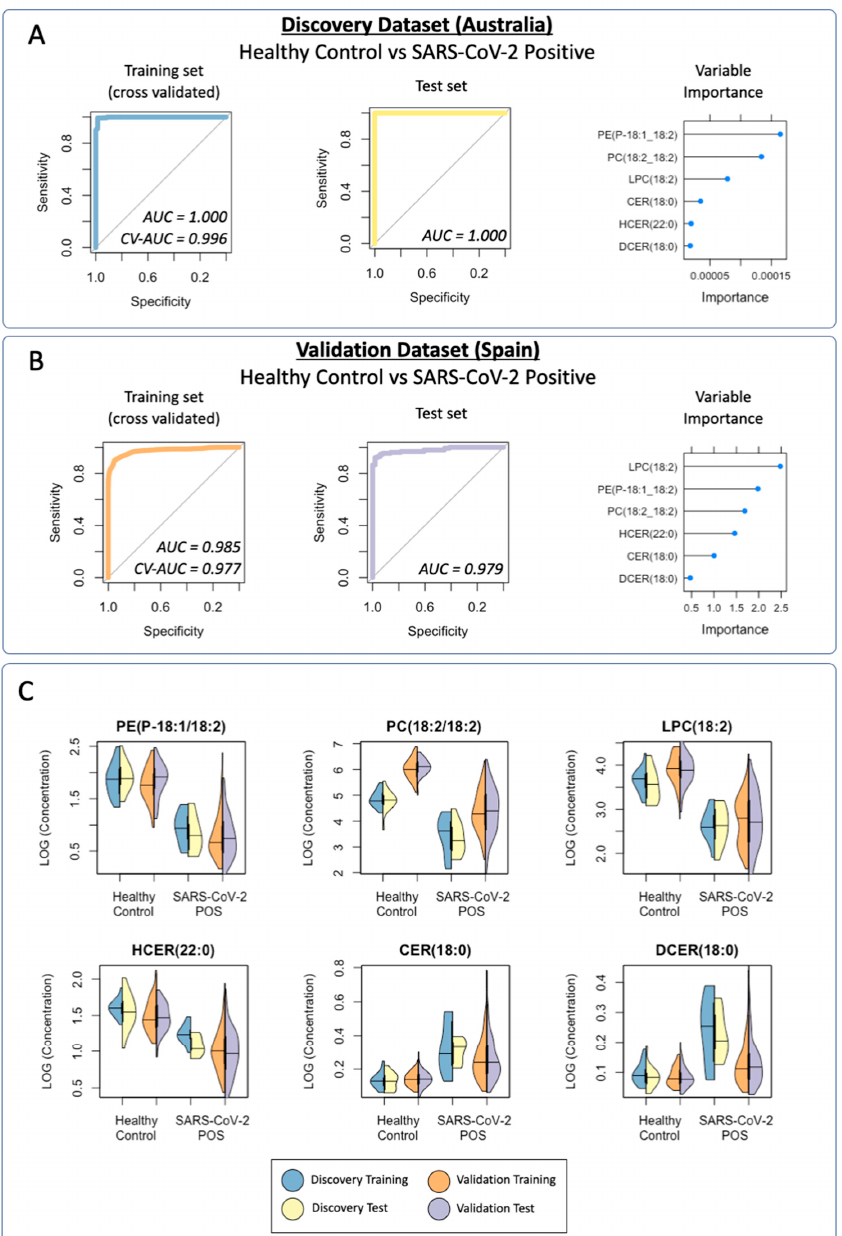
Figure 3. Cross-validated (CV) receiver operating characteristic (ROC) curves for the lipid logistic regression model for: ( A ) the discovery dataset (Australia) comparing SARS-CoV-2-positive individuals with healthy controls; training set (CV-AUC = 0.996, CV-sensitivity = 0.991, CV-specificity =0.909); test set (AUC = 1.000, sensitivity = 1.000, specificity = 0.944); ( B ) the validation dataset (Spain) comparing SARS-CoV-2-positive individuals with healthy controls; training set (CV-AUC = 0.977, CV-sensitivity = 0.855, CV-specificity = 0.948); test set (AUC = 0.978, sensitivity = 0.948, specificity = 0.922); ( C ) violin plots displaying the distribution of data acquired for the lipid panel. Both the discovery (training/test) and validation (training/test) cohorts demonstrated similar trends when comparing healthy controls to SARS-CoV-2- positive groups. Results of Mann–Whitney tests between the healthy control and SARS-CoV-2-positive groups for both the discovery and validation cohorts are reported in Table 2. The comparison of healthy control, SARS-CoV-2-negative, and SARS-CoV-2-positive groups can be found in Figure